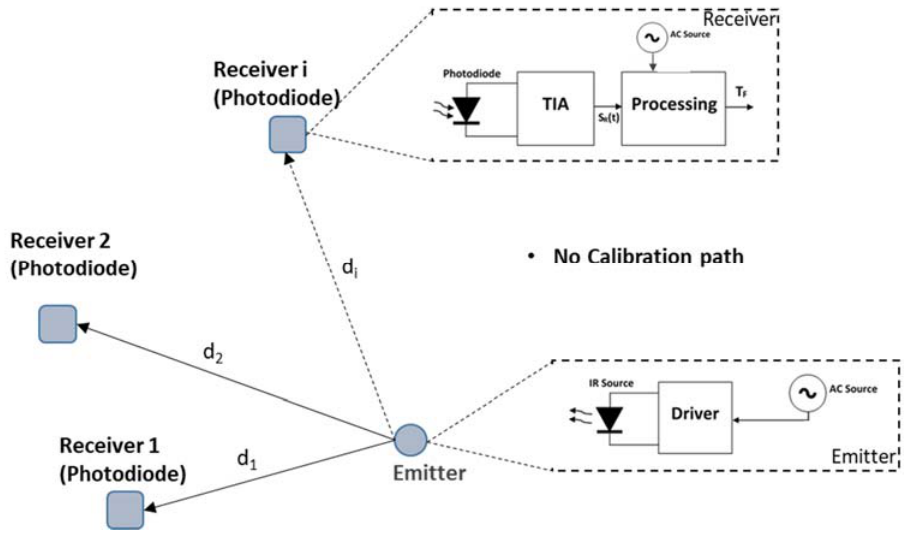
Figure 2. Optical distance measurement system with remote receivers where phase drifts may be critical.